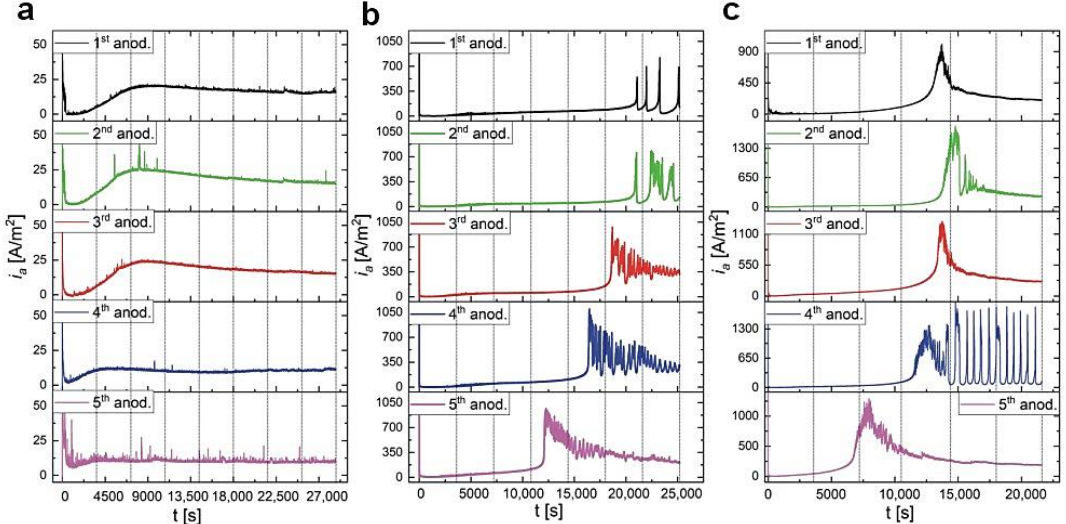
Figure 5. i a ( t ) curves recorded during anodization of aluminum in 0.15 M, 300 V ( a ), 0.25 M, 300 V ( b ), and 0.5 M, 250 V ( c ) malic acid concentrations and at temperature of 5 °C—the corresponding processes were repeated five times in a row in the same electrolyte (vertical dotted lines indicate the subsequent hours of anodization).